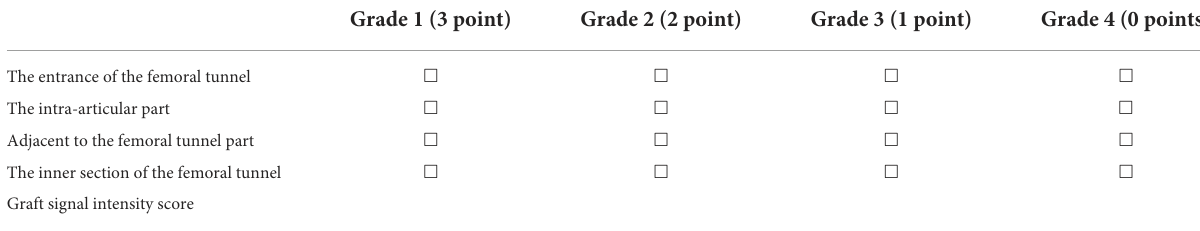
TABLE 1 The MRI graft signal intensity scale.